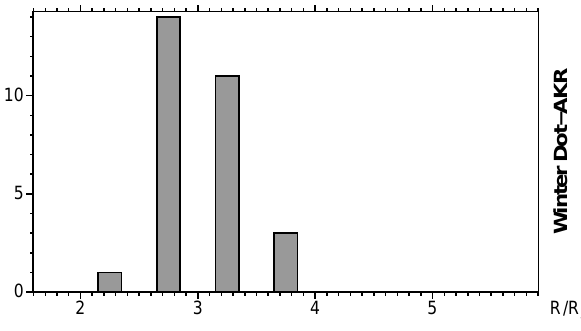
Fig. 4. Altitude-binned histogram of dot-AKR emission radial dis- tance during winter months (November–February) 1996–1997 ob- tained from Polar PWI instrument. The ordinate is the number of events. Adapted from panel (b) of Fig. 5 of Olsson et al.